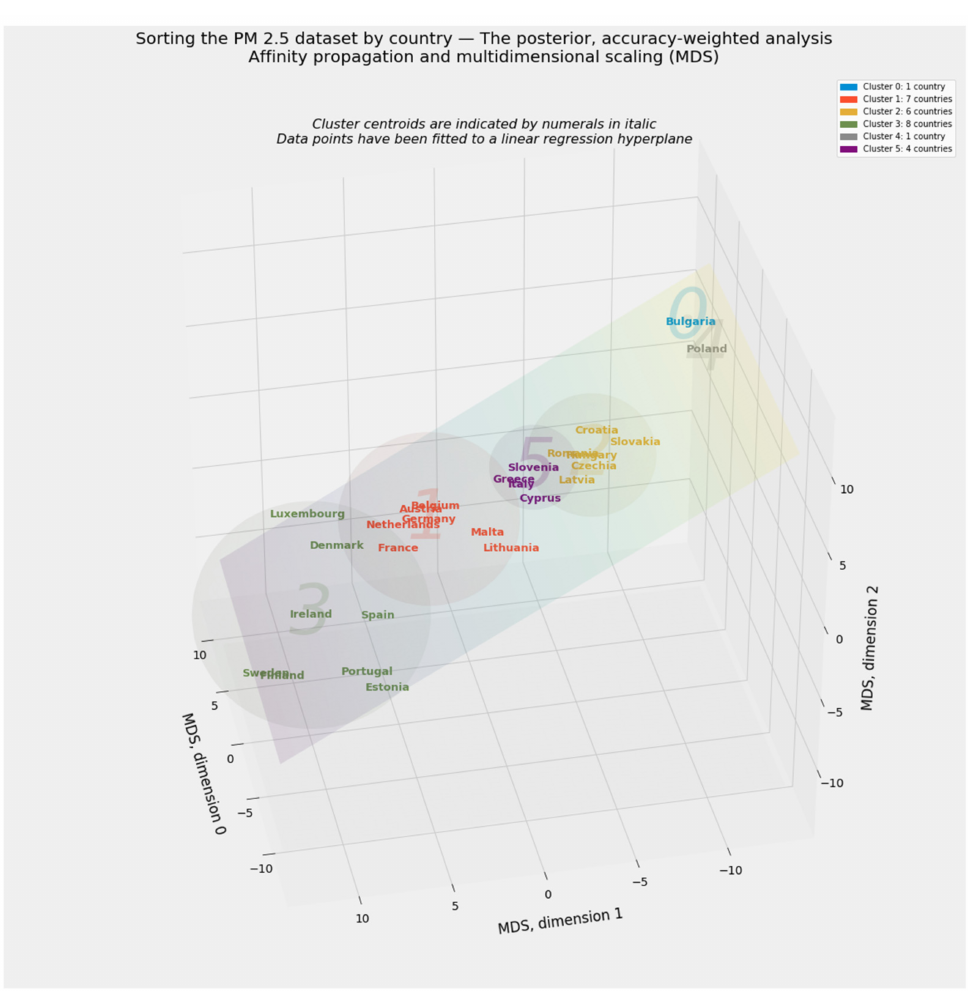
Figure 9. EU-27 clusters based on posterior, accuracy-weighted country-level aggregate